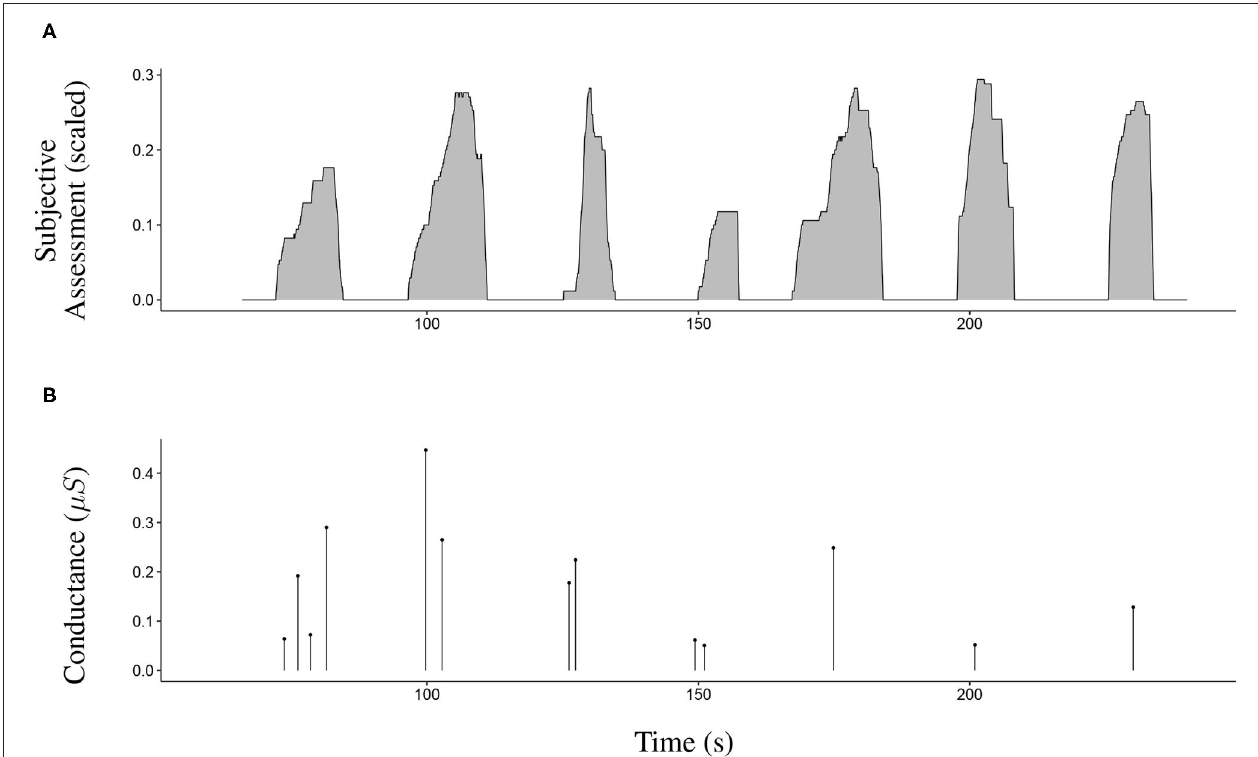
FIGURE 4 | Sample of the collected data concerning seven avoidance manoeuvres. (A) The evolution of the subjective assessment during seven avoidance manoeuvres. The subjective assessment always returned to 0 between the manoeuvres. Indicator mSA corresponds to the maximum value of each manoeuvre. Indicator iSA corresponds to the area under each curve. (B) The skin conductance responses during the seven avoidance manoeuvres. Indicator mSCR corresponds to the maximum amplitude of the responses. Indicator nSCR corresponds to the number of skin conductance